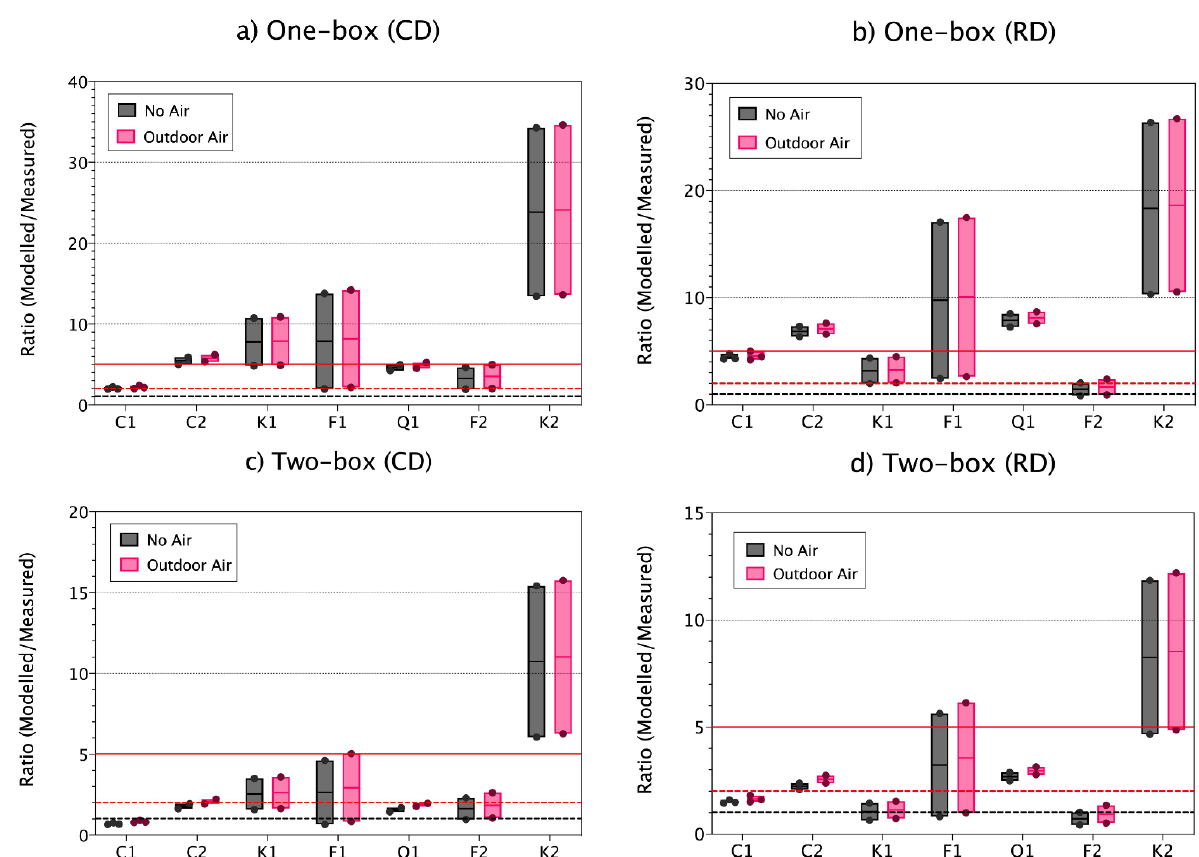
Figure 3. Vertical boxplot for ratio modelled/measured respirable concentrations for all materials without including incoming concentrations and including outdoor concentrations when using ( a ) CD as input for the one-box model, ( b ) RD as input for the one-box model, ( c ) CD as input for the two-box model and ( d ) RD as input for the two-box model. Ratios 1, 2 and 5 are marked as reference (red solid line, red dashed line and black dashed line, respectively). Solid coloured line within the box indicates the median value, and the limits of the box indicate min and max values. Coloured dots represent the individual replicate values. Modelling parameters: LEV and β fixed at 70% and 5 m 3 min −1 , respectively.